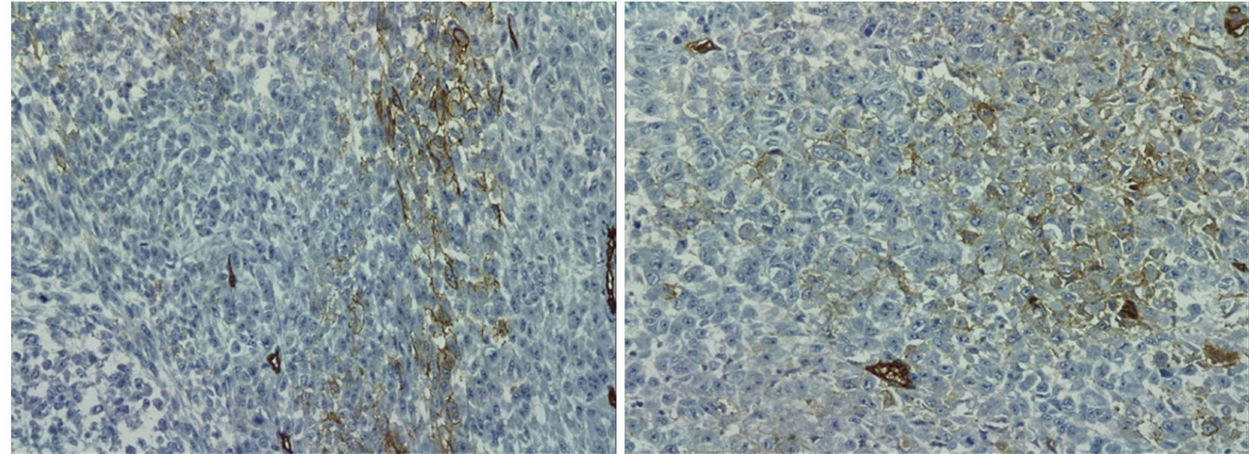
Figure 4. Immunohistochemistry images showing marker CD 34 positive for sternal chondrosarcoma.